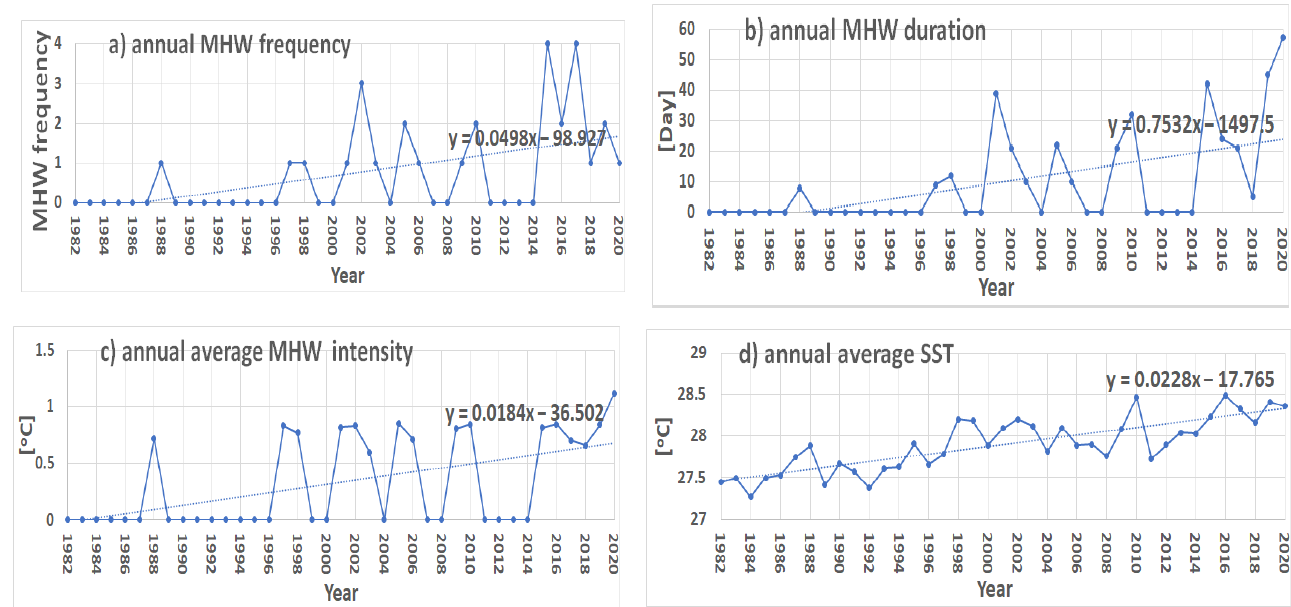
Figure 5. Sea surface temperature and marine heat wave properties over Red+.